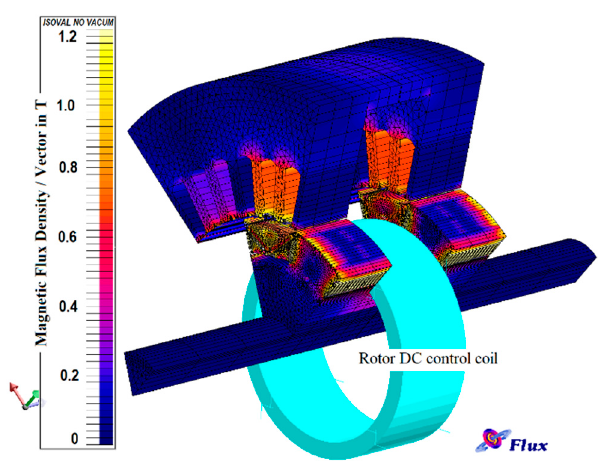
Figure 5. Three-dimensional finite element analysis (3D FEA) results of no-load magnetic flux density distribution on HESM.